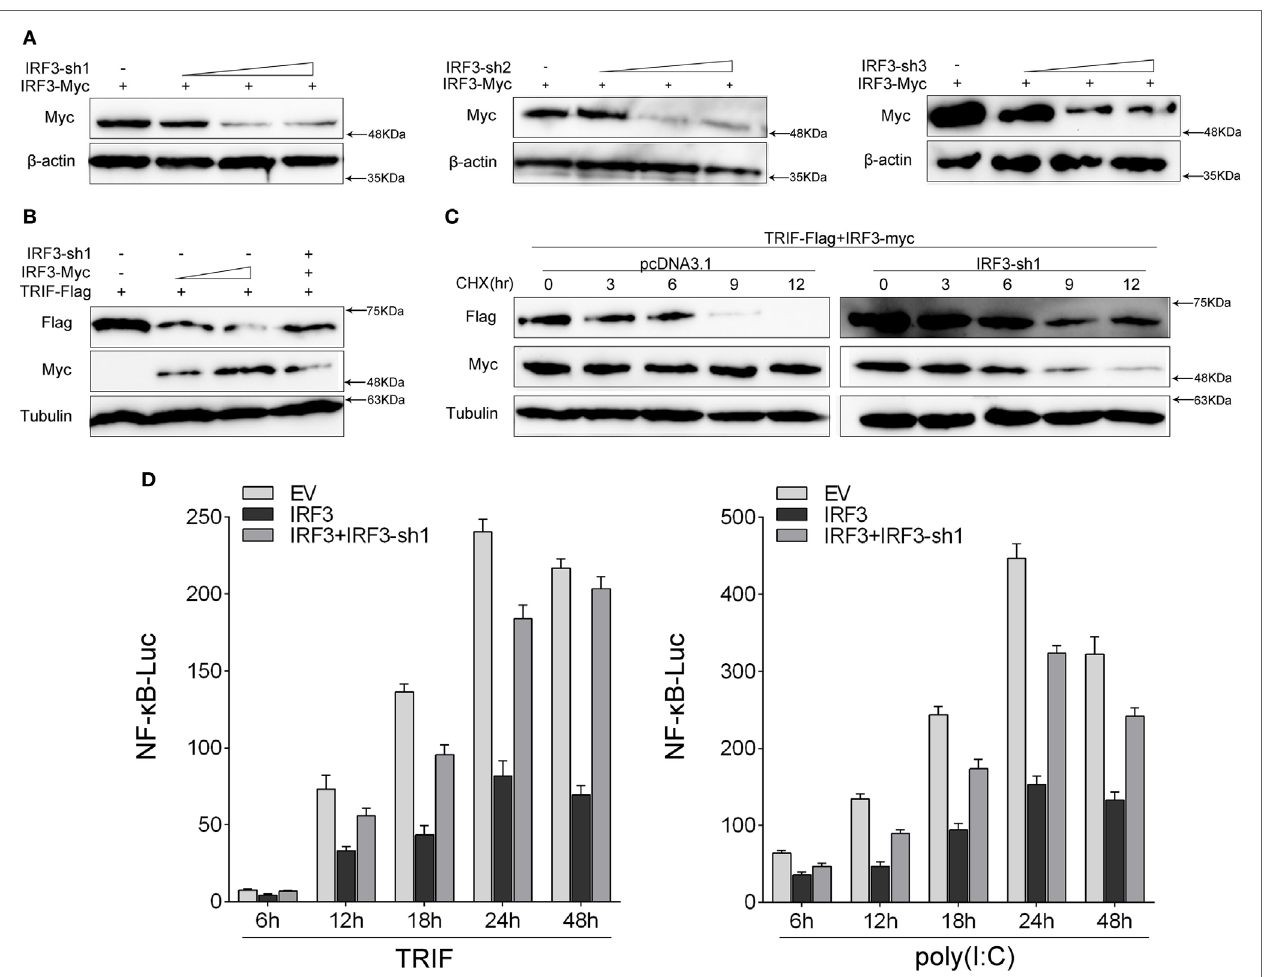
FigUre 6 | Knockdown of IRF3 relieves the degradation of TRIF and potentiates TLR-mediated NF- κ B pathway. (a) The IRF3, a different concentration of IRF3-sh1, IRF3-sh2, or IRF3-sh3 plasmids were transfected into HEK293 cells, after 48 h, IRF3 protein levels were determined by immunoblot assays and normalized to β -actin. (B) HEK293 cells were co-transfected with TRIF, IRF3, and IRF3-sh1, after 48 h, TRIF protein levels were determined by immunoblot assays and normalized to tubulin. (c) HEK293 cells were co-transfected with TRIF, IRF3, and IRF3-sh1 plasmids, at post-transfection 36 h, cells were treated with cycloheximide (100 µg/ml), then cells were lysed at different time point and the expression of TRIF was examined by immunoblot assays. TRIF protein levels were normalized to tubulin. (D) HEK293 cells were co-transfected with TRIF, IRF3, IRF3-sh1, together with NF- κ B, the luciferase activity was measured at different times (left); after co-transfected with IRF3, IRF3-sh1 plasmid, and NF- κ B for 36 h, and then stimulated with poly(I:C) for different times, the luciferase activity was measured (right). The luciferase activity value was achieved against the Renilla luciferase activity. * p < 0.05 versus the